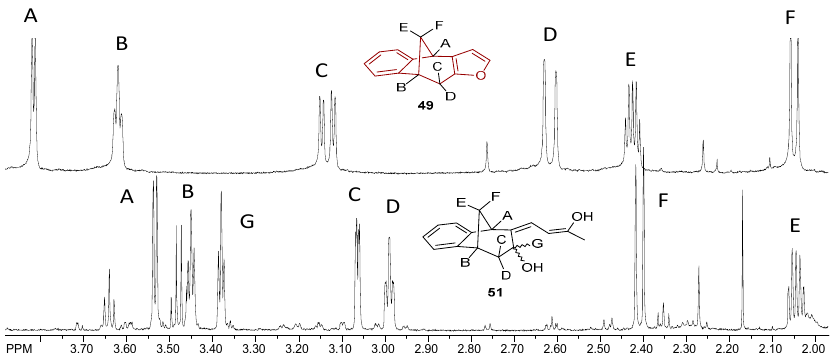
13 of 25 Figure 13. Isolated products of acylation reaction. The structure and purity of the synthesized products of acylation were confirmed by NMR techniques as well as High Resolution Mass Spectrometry (HRMS) analyses (see experimental and Figure 14). In comparison with the aliphatic part of the proton NMR spectrum of 49 and characteristic